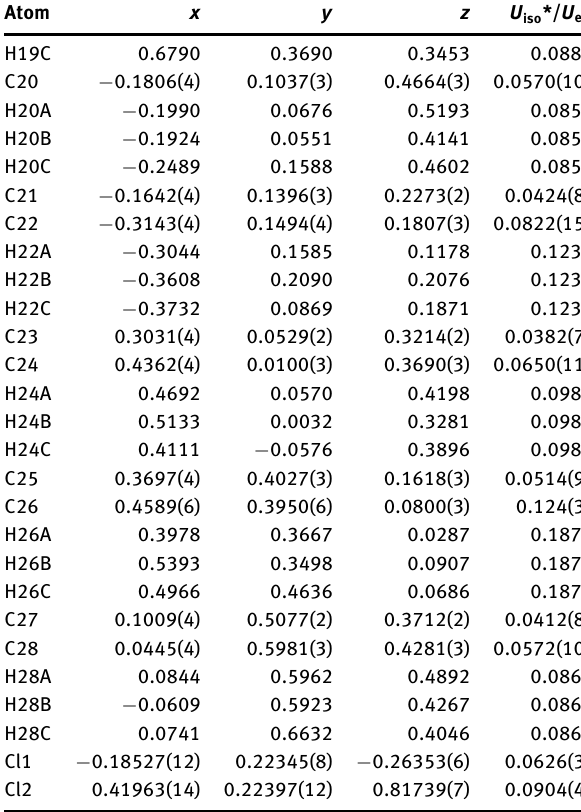
Table 2: Fractional atomic coordinates and isotropic or equivalent isotropic displacement parameters (Å 2